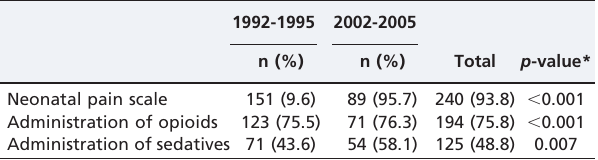
Table 3 - Pain and distress